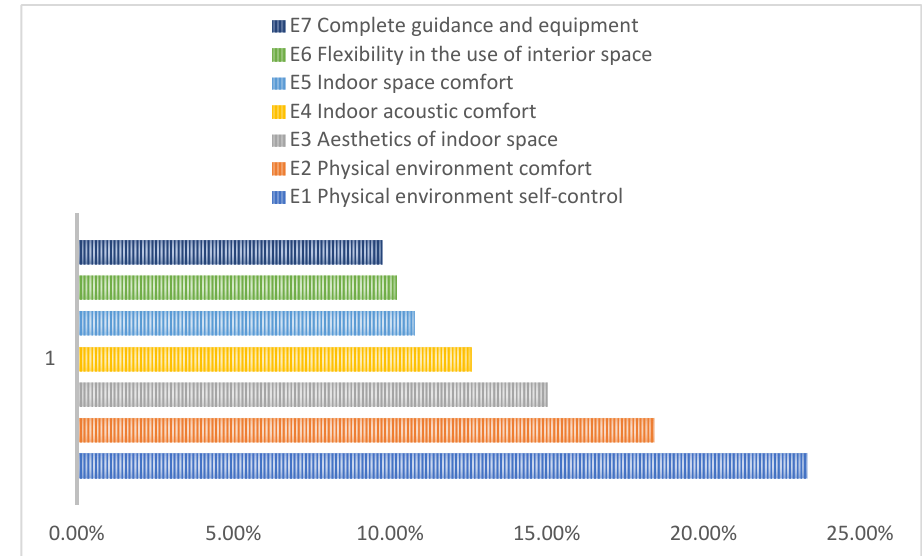
Figure 5. Contribution of spatial factors.